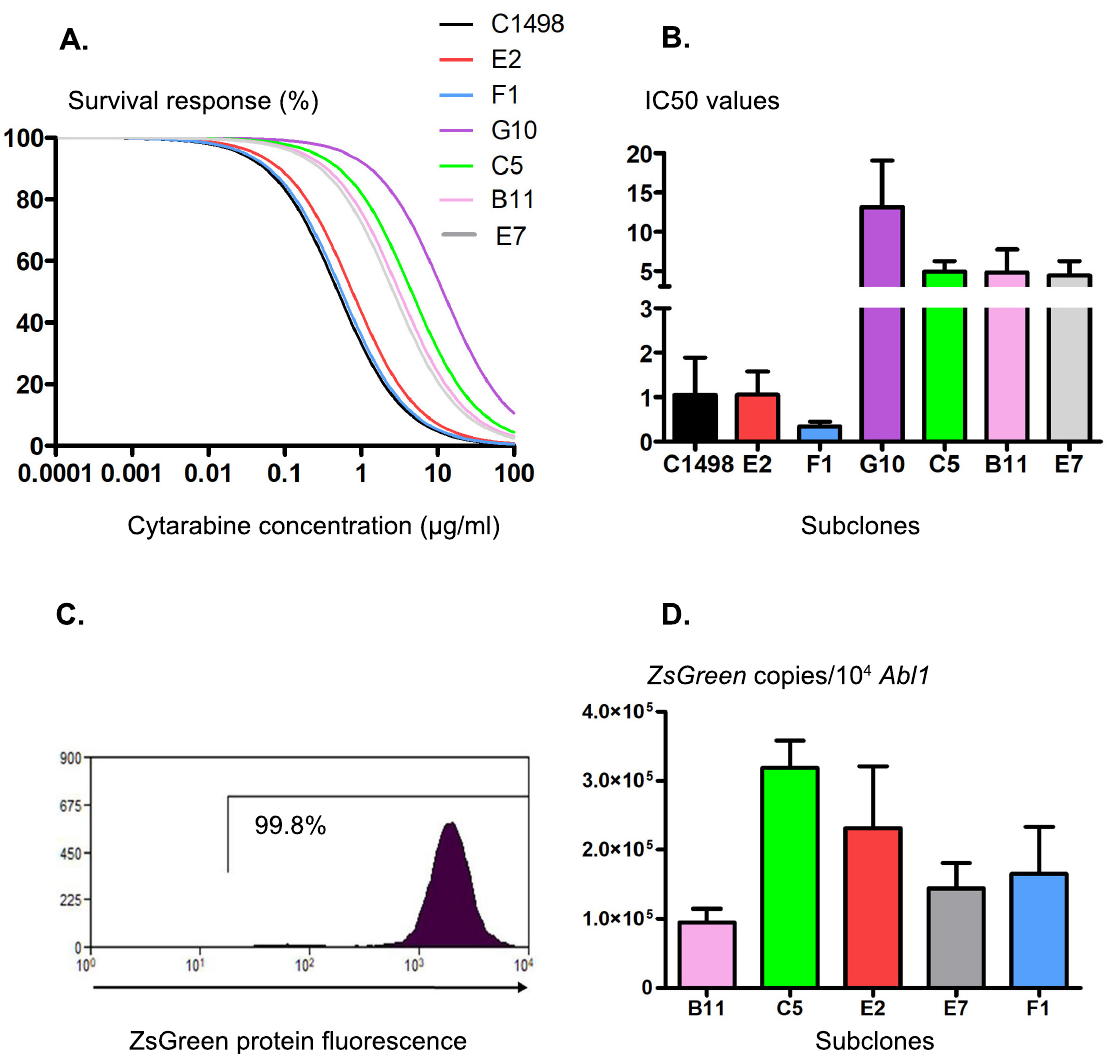
Fig 1. Ara-c sensitivity of the different leukemic ZsGreen -expressing subclones. (A) In vitro survival responses of the different subclones to increasing cytarabine concentrations and (B) representation of the cytarabine sensitivity of the different cell lines using IC50 values. The results are represented as the mean from 3 independent experiments for each subclone starting at cytarabine concentrations of 10 − 4 μ g/ml (100% survival). (C) Representative flow cytometry histogram of ZsGreen protein expression in each subclone. (D) ZsGreen gene expression in each subclone determined by RT-qPCR. The number of ZsGreen transcript copies was normalized to 10 4 copies of Abl1 using a plasmid reference curve.